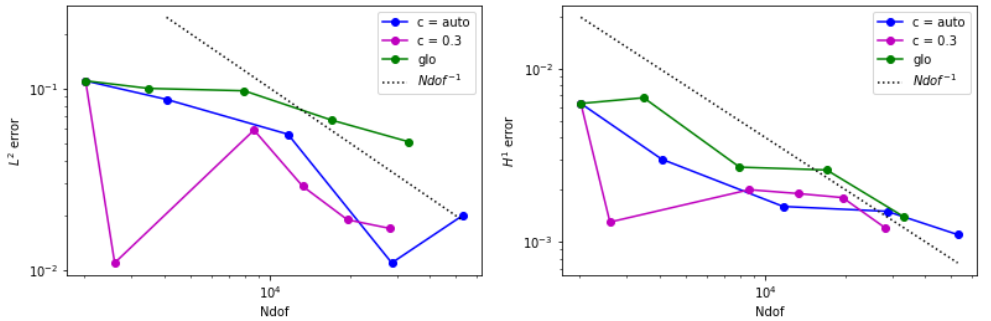
Figure 19. Error behavior for example 3 when η Z is adopted. ( Left ) The estimated L 2 norm of the error is displayed. ( Right ) The estimated H 1 seminorm is shown.